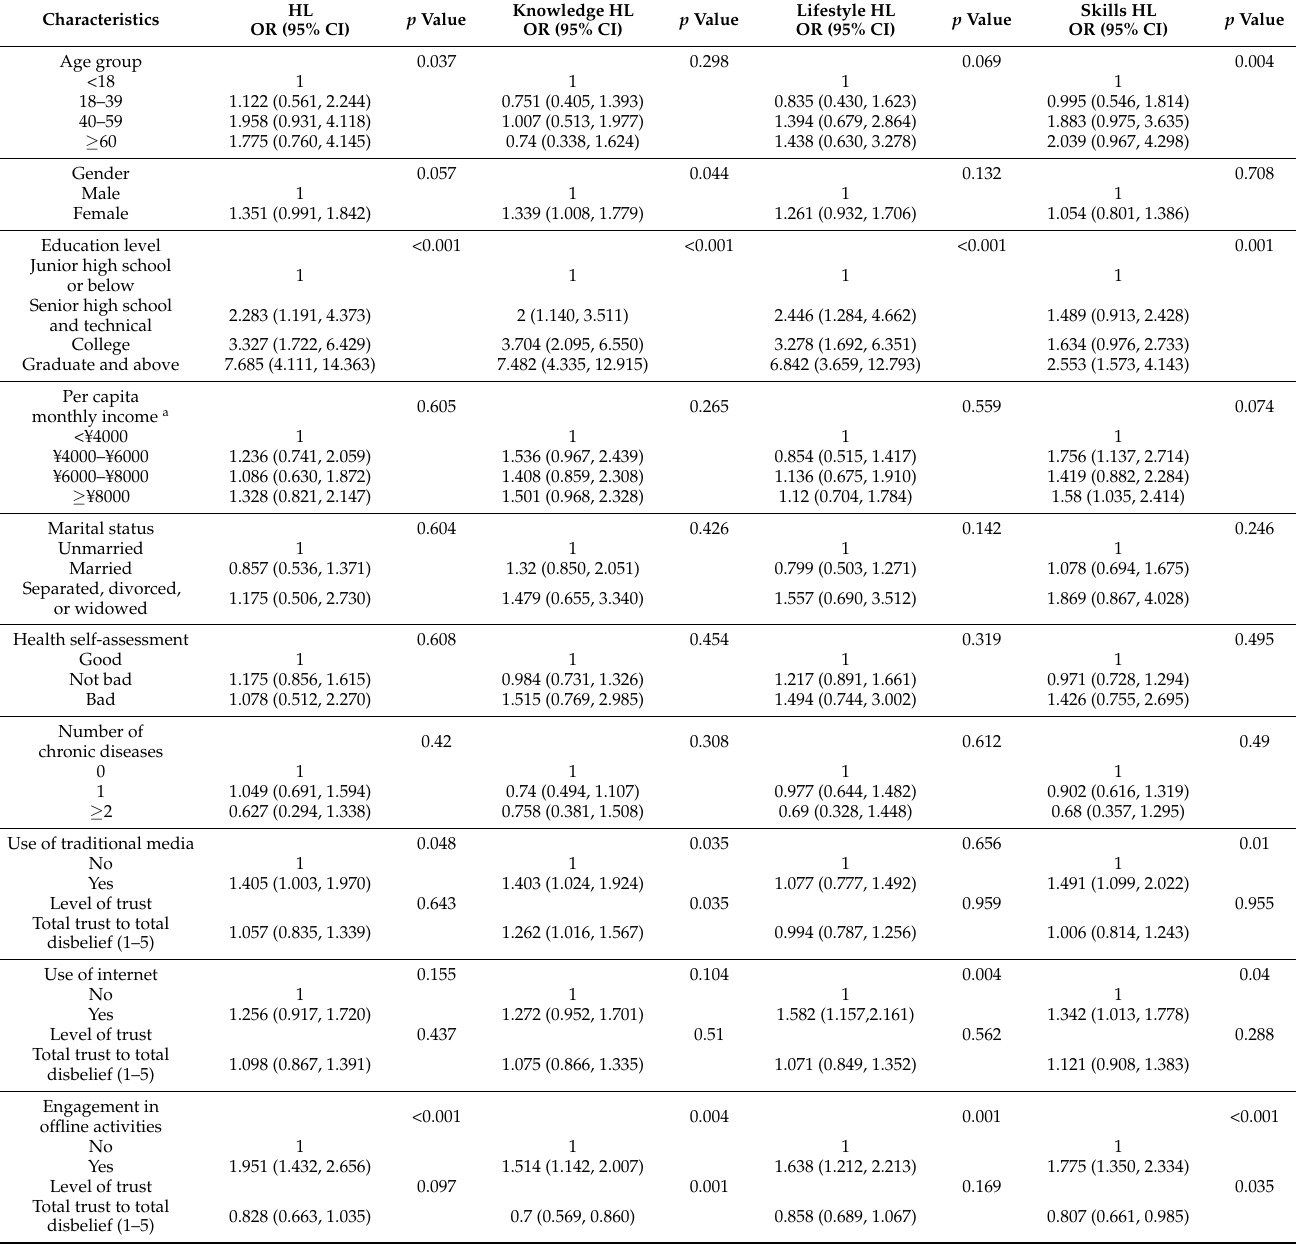
Table 3. Logistic analysis of the predictors of health